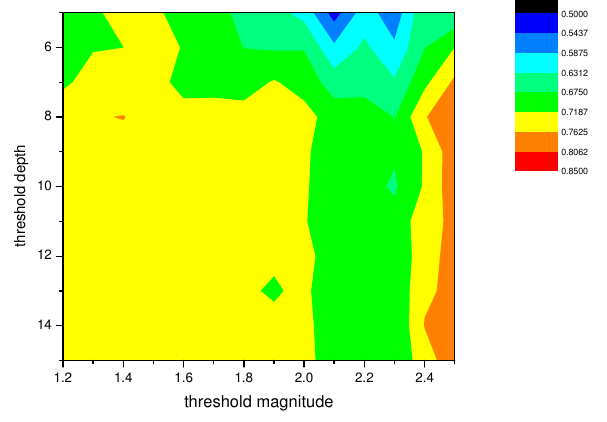
Fig. 10. Scaling exponents d S estimated by performing the DFA over the interdistance time series changing the threshold magnitude and the threshold depth.